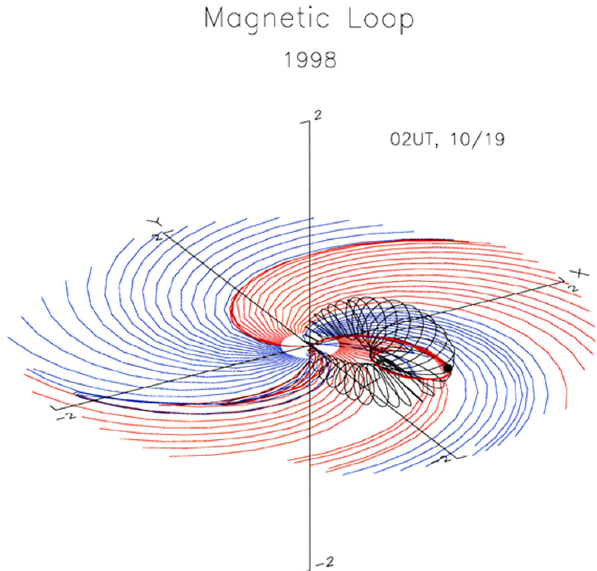
Fig. 23a. Some CMEs contain a helical magnetic structure (Saito et al., 2007).